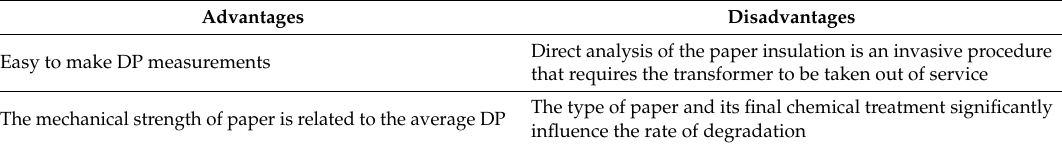
Table 3. Advantages and disadvantages of degree of polymerization (DP) measurement